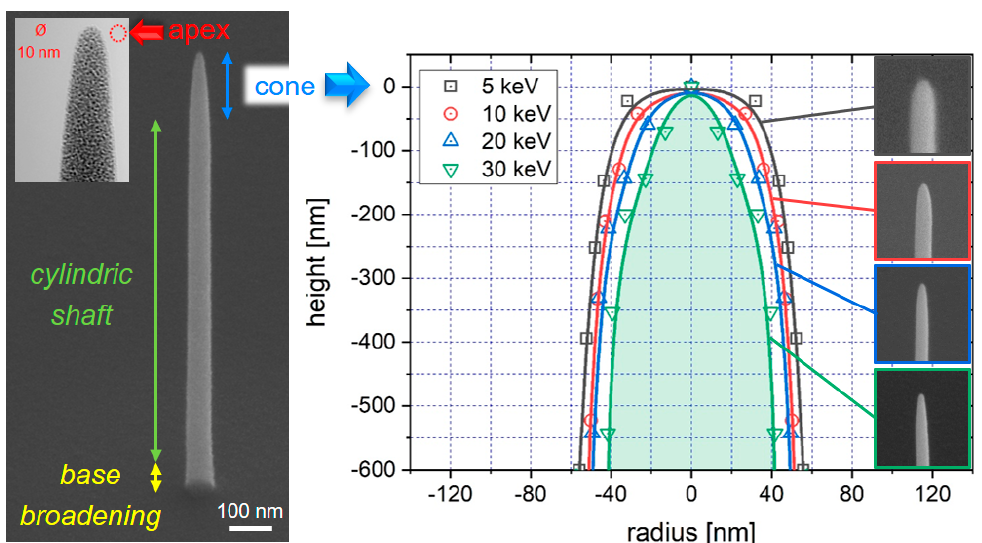
Figure 2. FEBID nano-pillar characteristics. The tilted scanning electron microscope (SEM) image at the left shows the typical nano-pillar morphology, which can be categorized into three vertical sections: a slightly broader base section close to the substrate, a cylindrical shaft region, and the topmost cone, terminated by the apex. The latter can exhibit tip radii down to 5 nm, as shown by the transmission electron microscopy (TEM) inset top left. While the shaft length is proportional to the growth time, the vertical expansion of the conical region scales with the primary electron energy due to the varying mean free paths of electrons, statistically described by the interaction volume. The vertical expansion of the latter decreases with lower primary energies, which explains the higher curvature of the tip region (compare 5 keV/squares with 30 keV/inverted triangles). The insets show representative SEM images of the tip region in a titled view.